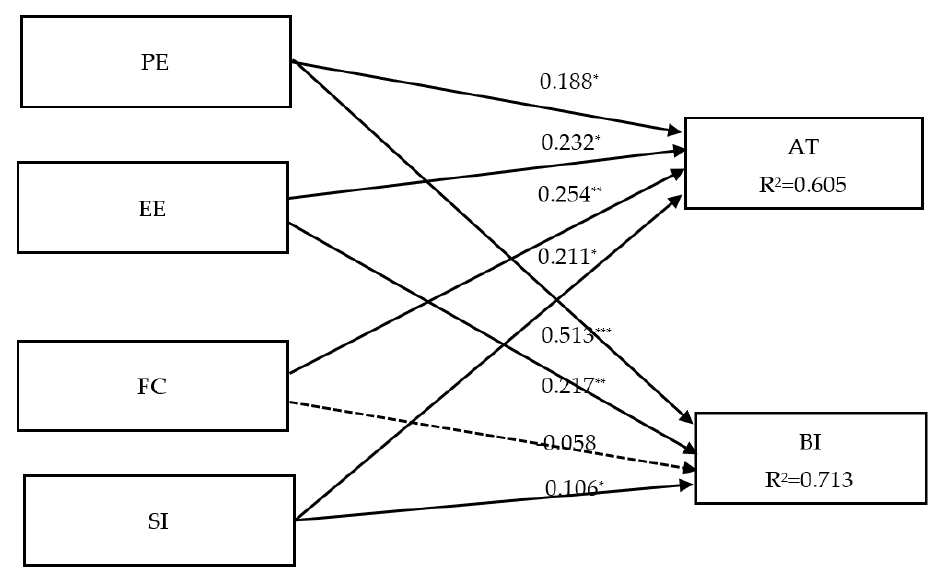
Figure 1. Structural model analysis results. Note: * p < 0.05; ** p < 0.01; *** p < 0.001.